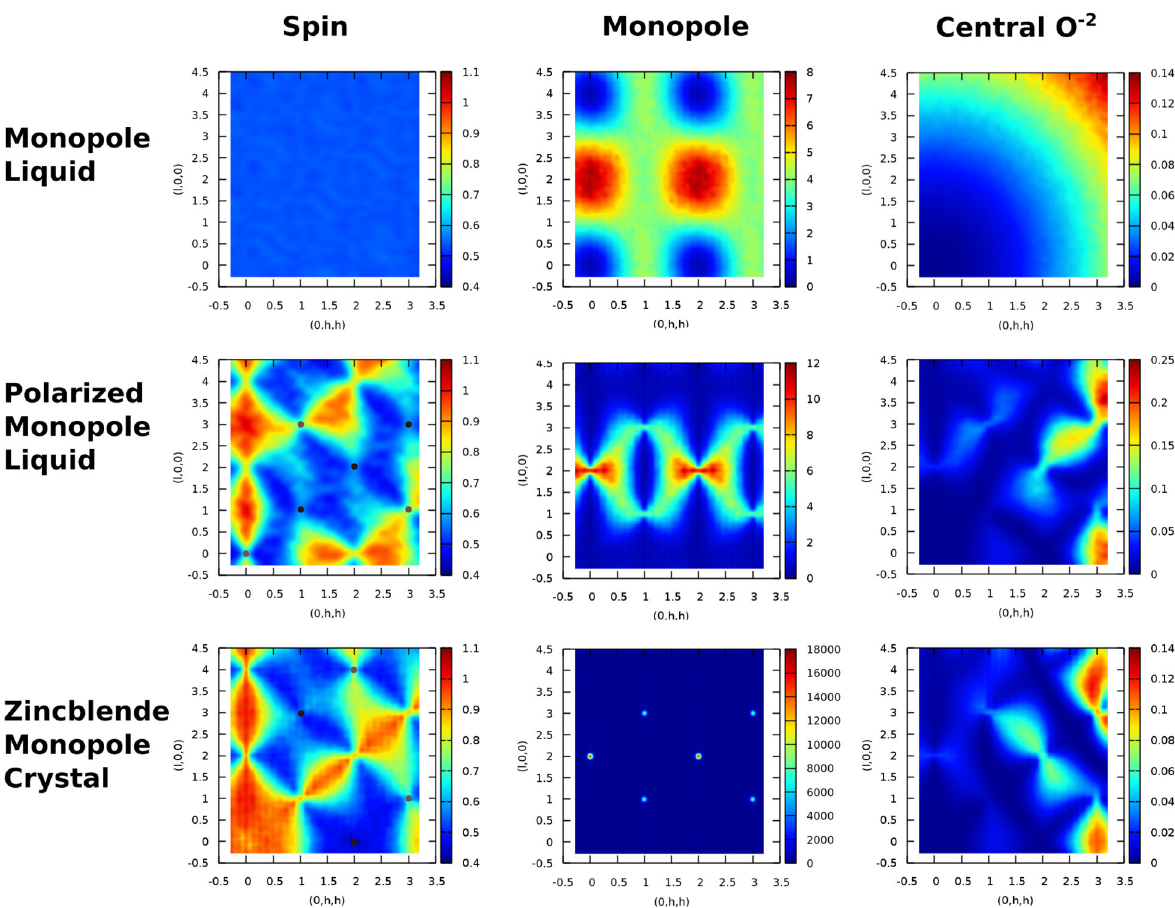
Fig. 6 Structure factors for the different disordered phases. The Magnetoelastic Spin Ice model (MeSI) considers on an equal footing the elastic and magnetic degrees of freedom. The structure factor shows this in a very illustrative way. In this array, the nature of the scattering centre (spins, single monopoles, or the oxygen ions near the centres of the tetrahedra) varies along the horizontal axis (see Supplementary Note 3 for details on the structure factor calculation). The names of three of the studied phases are indicated on the left, with increasing charge order (while not necessarily spin order) progressing downwards. For scattering from O − 2 ions we have omitted the Bragg peaks corresponding to their position in the regular pyrochlore lattice; on the other hand, Bragg peaks from the fragmented divergence-full component of the magnetic moment in the Zincblende Monopole Crystal (ZnMC), or by the spins aligned by the applied magnetic fi eld along [100] in the Polarised Monopole Liquid (PML), are indicated schematically by full circles. Notably, three different types of gauge fi eld can be observed, associated with spins, magnetic charges, and oxygen displacements. While the Monopole liquid does not show pinch points in any case, the PML is most remarkable, re fl ecting the existence of a Coulomb phase in the three channels. In principle, the Fragmented Coulomb Spin Liquid 26,31,84 should re fl ect the existence of a Coulomb phase not only through the magnetic moments, but also through